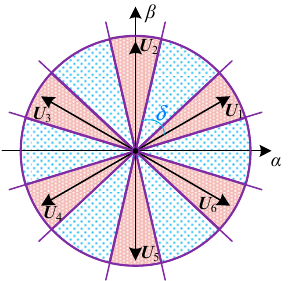
Figure 6. Vector space division for active power.